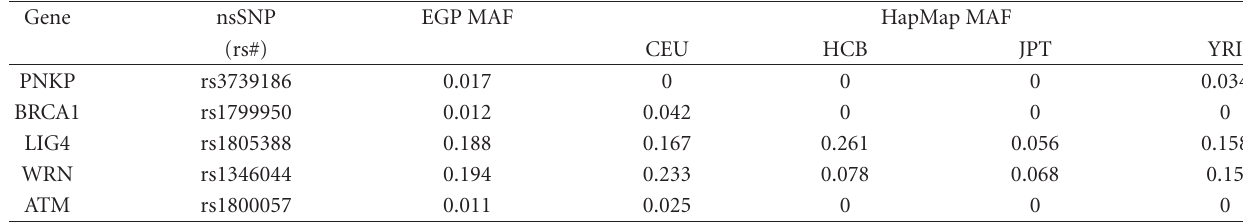
Table 2: Minor allele frequency for selected